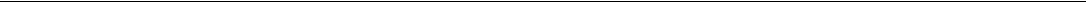
Fig. 7 Long term in vivo and in vitro analysis of PUMA gene transfer. Rat ankle joints were injected with HAdV5-PUMA alone, or BV CAR HAdV5-PUMA at a vector dose of 10 9 HAdV5-PUMA per joint, after the onset of arthritis at day 14. The parameters monitored over a period of 21 days were the a ankle articular index, b loss of function index, c ankle circumferences and d body weights. Histology was performed on undecalci fi ed samples with various staining. Tartrate-resistant acid phosphatase (TRAP) staining provided red colour in multinucleated osteoclasts on the bone counter-stained with Anilin blue e . Compared to HAdV5-PUMA group, TRAP+osteoclast staining with the TRAP was reduced at several sites of the ankle area, including distal tibia, talus, calcaneus and navicular bones in the HAdV5-PUMA group. Arrows showed important TRAP+ osteoclast concentration in the bones. In the same sites, the bone matrix was stained with Goldner trichrome staining f . Mineralized matrix was stained in green, while non-mineralized matrix was stained in red and the marrow in yellow. Arrows showed loss of bone mineral. More mineralized trabeculae and less non-mineralized areas were observed in the bones of the BV CAR HAdV5-PUMA group in comparison with the HAdV5-PUMA group f . Then, Safranin O – Fast green staining was performed with bone tissue staining in turquoise and cartilage staining in red g . Compared to HAdV5-PUMA, cartilage thickness and its regularity were preserved in the BV CAR HAdV5-PUMA group. Arrows indicated the loss of mineral in the bones. In fl ammatory in fi ltrate (indicated by the ‘ i ’ ) was importantly diminished in the HAdV5-PUMA group and the bone cavity conserved its histological integrity. Scale bar, 500 µ